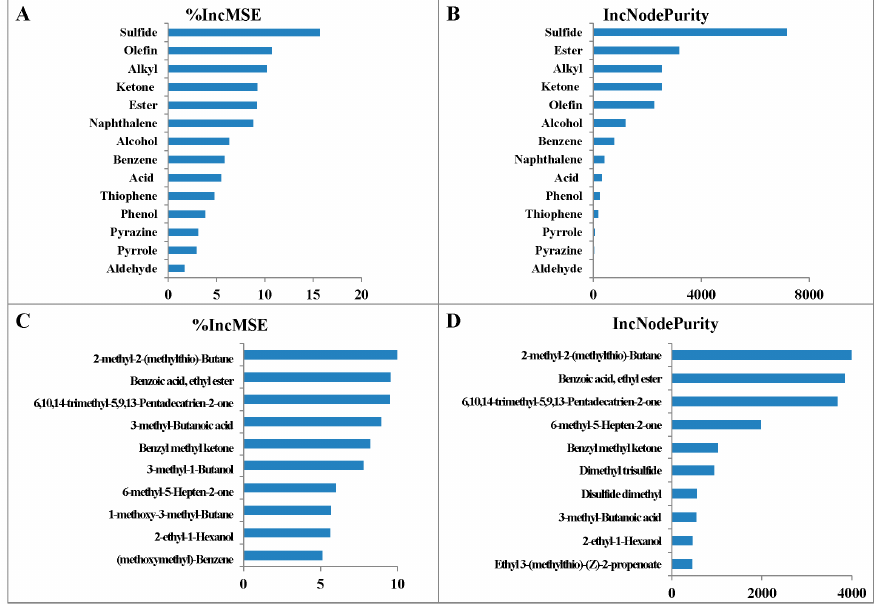
Figure 4. Random forests variable importance plot of different types VOCs (( A ): % IncMSE, ( B ): IncNodePurity)) and random forests variable importance plot of different individual VOCs (( C ): % IncMSE, ( D ): IncNodePurity)). % IncMSE: Relative importance.